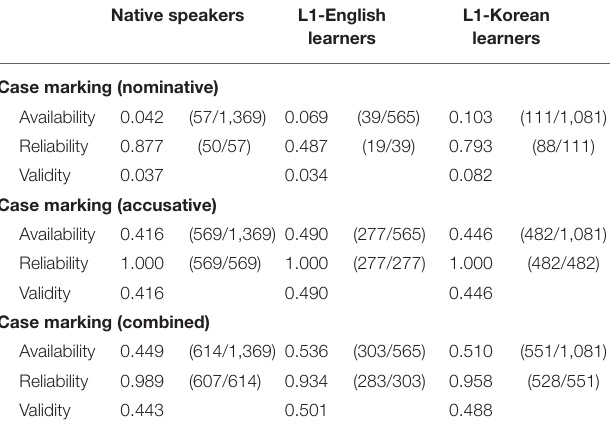
TABLE 9 | Availability, reliability, and validity of case-marking cues in all sentences. Native speakers